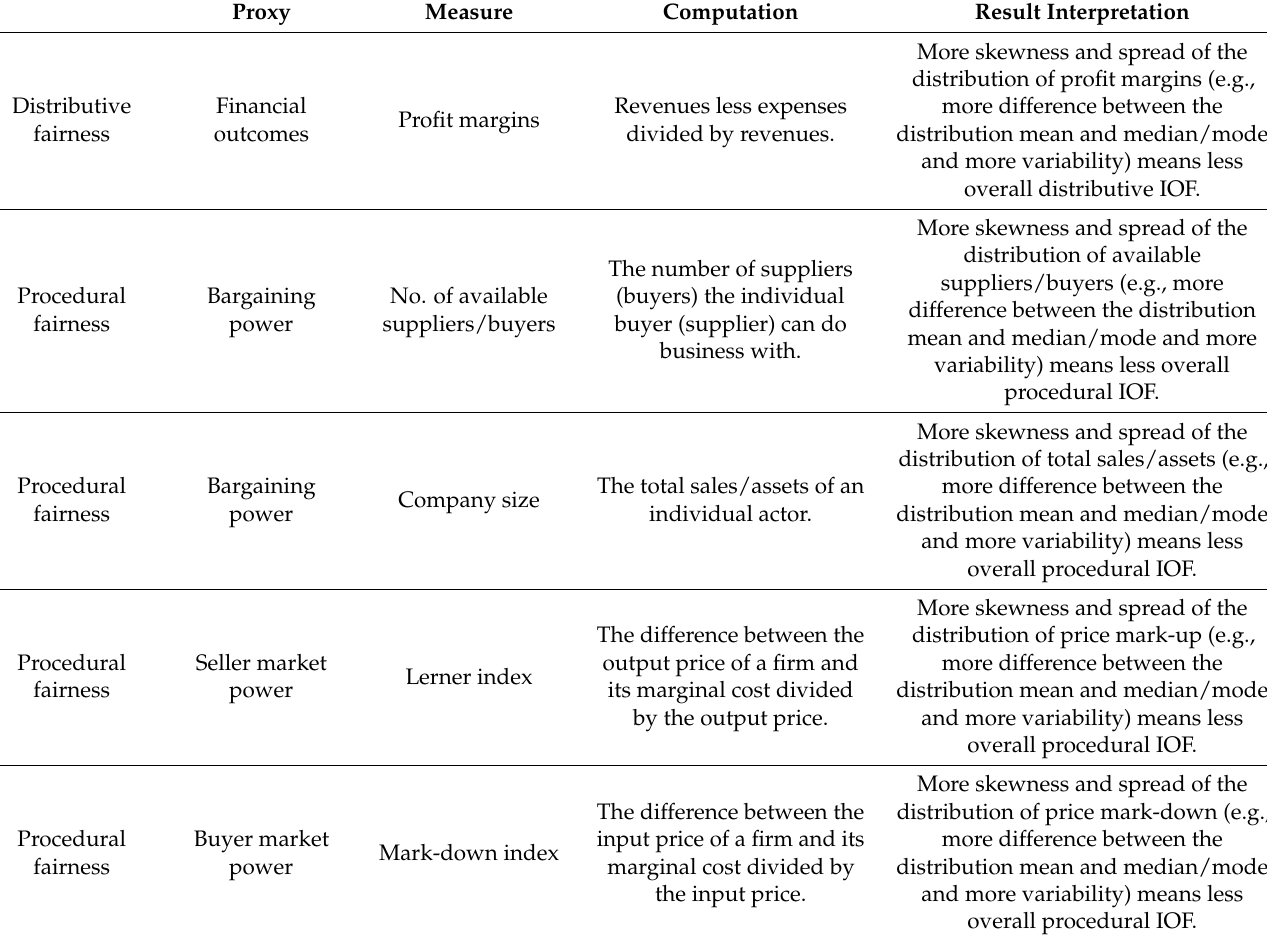
Table 3. Resulting indicators of IOF including computational method and result